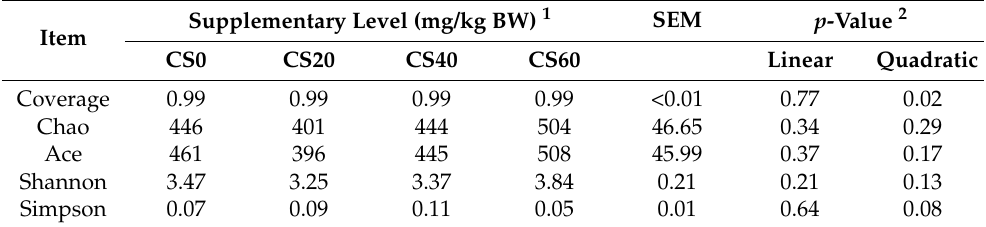
Table 5. Effect of dietary CS addition on ruminal bacteria alpha diversity based on OTUs.